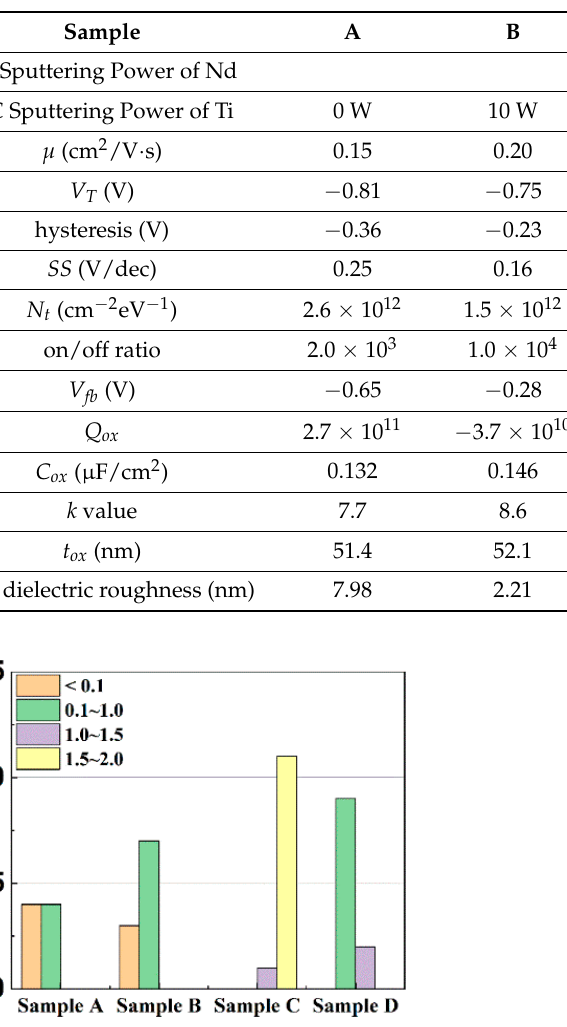
Figure 5. Carrier-mobility distribution for pentacene OTFTs with increasing Ti content in gate dielectric. Table 1. Main electrical parameters of OTFTs with increasing Ti content in gate dielectric.